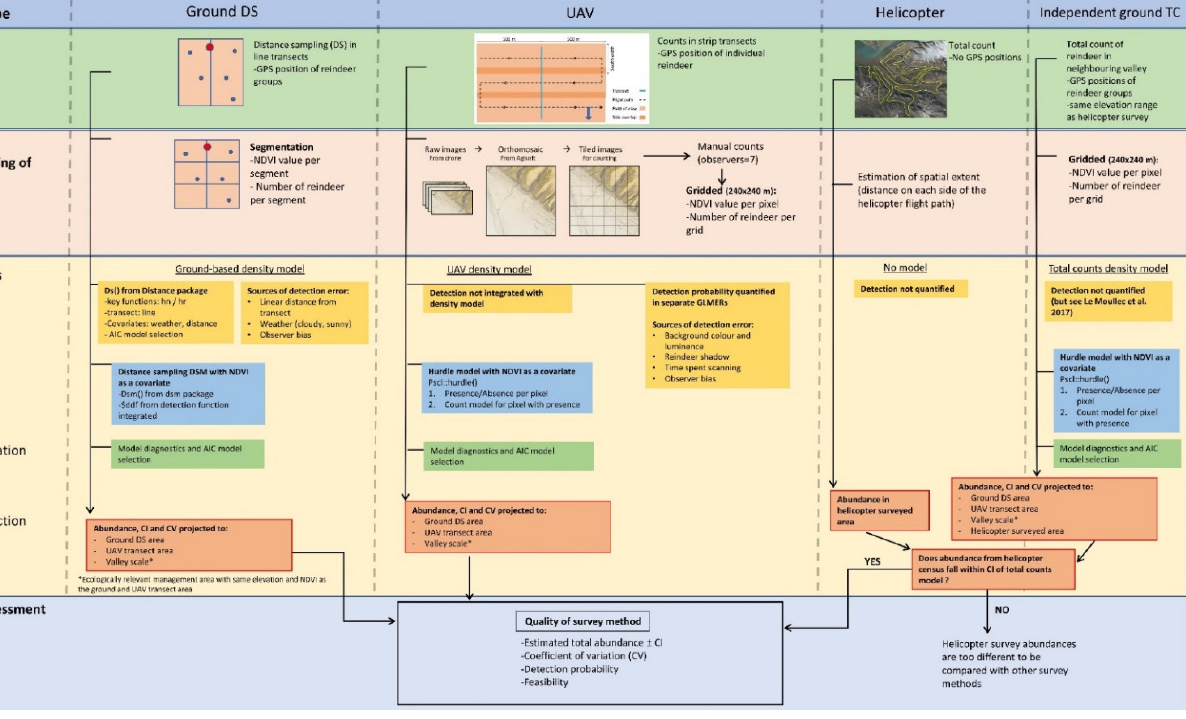
Figure 2. Visualisation of the workflow, including field survey design, postprocessing and data analysis of the four survey methods ground distance sampling (ground DS), UAV, helicopter, and independent ground total counts (independent ground TC).